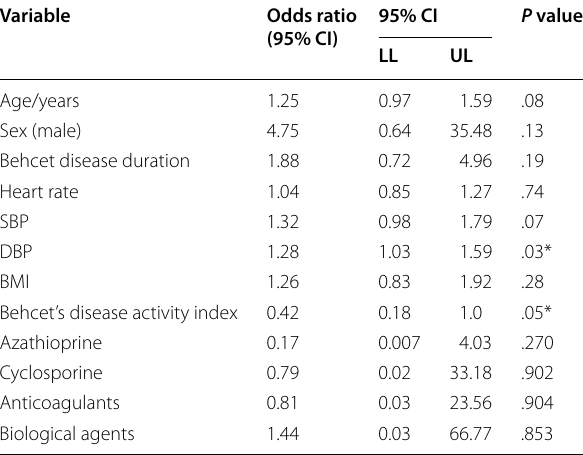
Table 4 Logistic regression analysis for of independent predictors associated with abnormal cardiac MRI in the studied patients (n =